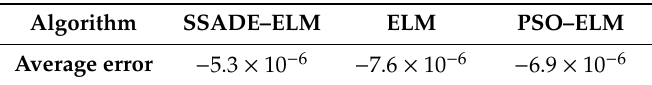
Table 4. The average error of joint tracking of control algorithms by experiment. (SSADE–ELM = Strategy Self-Adaptation Di ff erential Evolution–Extreme Learning Machine, PSO–ELM = Particle Swarm